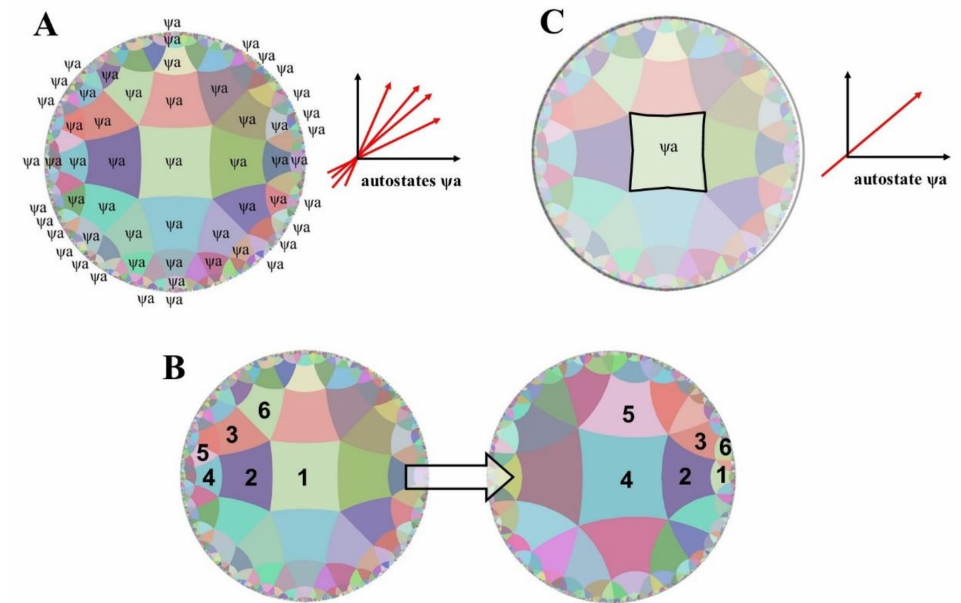
Figure 1. An observable of a QM system is portrayed in terms of a collection of tiles on a hyperbolic Poincar é disk. The tiles are painted in different colors to emphasize that each tessellation corresponds to a single autostate ψ a. ( A ) Before the experimental measurement of the observable A, all the autostates ψ a are detectable, and no preferential autostate can be chosen. The wave function of the autostates ψ a is described by a sheaf of vectors lying on orthonormal basis (right Figure). ( B ) The operations occurring on the Poincar é disk permit the movement of every tile. For the sake of clarity, some of the tiles are numbered to show their movements from the initial state (left) to the final state (right). In long periods of time, every QM wave necessarily crosses the central tile of the Poincar é disk: to provide an example, the peripheral tile 4 in the left figure moves towards the center of the disk in the right figure. ( C ) After the experimental measurement of the observable A, the system collapses, and a single “frozen” autostate ψ a becomes detectable in our observation frame, i.e., in the central tile. The wave function of the autostates ψ a is now described by a single vector lying on orthonormal basis (right Figure). Modified from: Rendering Hyperbolic Spaces—Hyperbolica Devlog #3 (https://www.youtube.com/watch?v=pXWRYpdYc7Q, accessed on 30 December